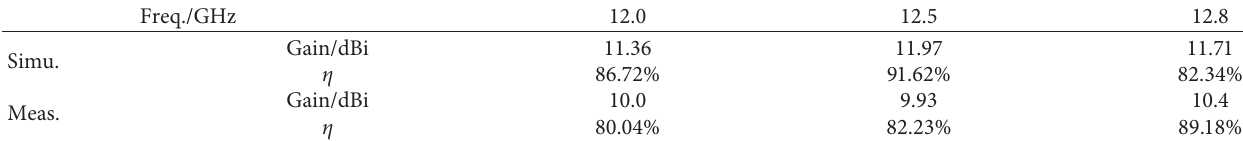
Table 2: Realized gain and radiation efficiency at different frequency points. Freq./GHz Simu.